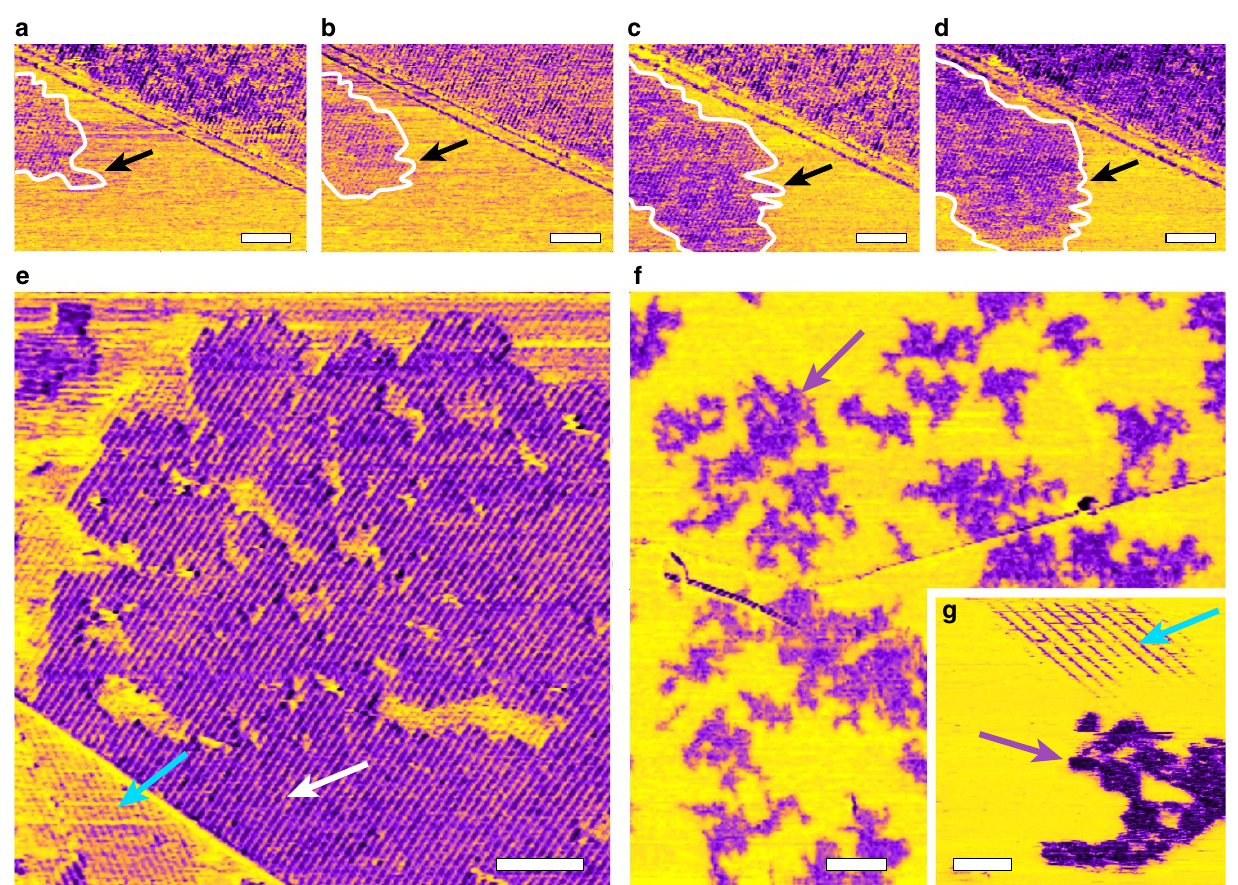
Figure 4 | Thermally-activated formation of organized water-MeOH structures. All images are phase images, displayed in the topography colour scale only in this figure for better contrast. The full set of data is available in Supplementary Fig. 9. The growth of row domains can be followed in real time ( a – d ). The temperature is 40 ± 0.1 (cid:2) C (measured in the metal piece supporting the HOPG) and the time between consecutive frames is 36s. The edge of the growing domain is delineated in white and indicated with a black arrow. Once the surface is fully covered with rows (blue arrow in e ), the second layer of rows (white arrow) can form on top of the first layer. Its thickness is about 2.9Å (Supplementary Fig. 11). The process is enhanced by increasing temperature (here 45 ± 0.1 (cid:2) C). At low MeOH concentration (here 5%) ( f ) higher temperatures are required to nucleate stable interfacial structures, which do not cover the whole HOPG surface (purple arrow). Higher magnification ( g ) reveals the coexistence of rows (blue arrow) and 2D structures such as those shown in Fig. 2d (purple arrow). The temperature is 60 ± 0.1 (cid:2) C in ( f ) and ( g ). The scale bars are 50nm ( a – e ), 100nm ( f ) and 20nm ( g